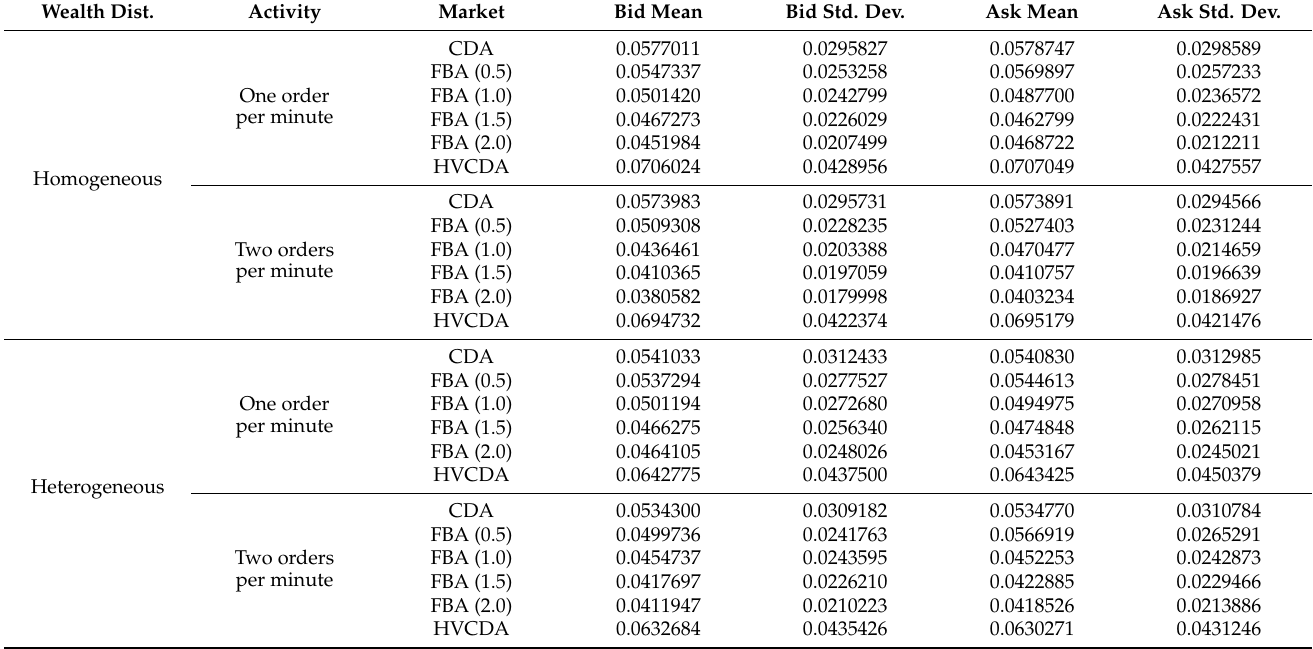
Figure 8. Limit order book average shape. ( a ) CDA. ( b ) FBA (0.5). ( c ) FBA (1.0). ( d ) HVCDA. ( e ) FBA (1.5). ( f ) FBA (2.0). Table 4. Summarized limit order book average shape statistics. All amounts are in